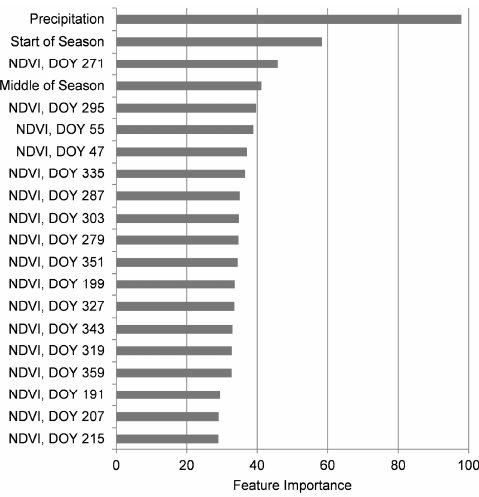
Figure 8. Mean feature importance of the 20 most important features for the years 2001–2014 scaled between 0 and 100.